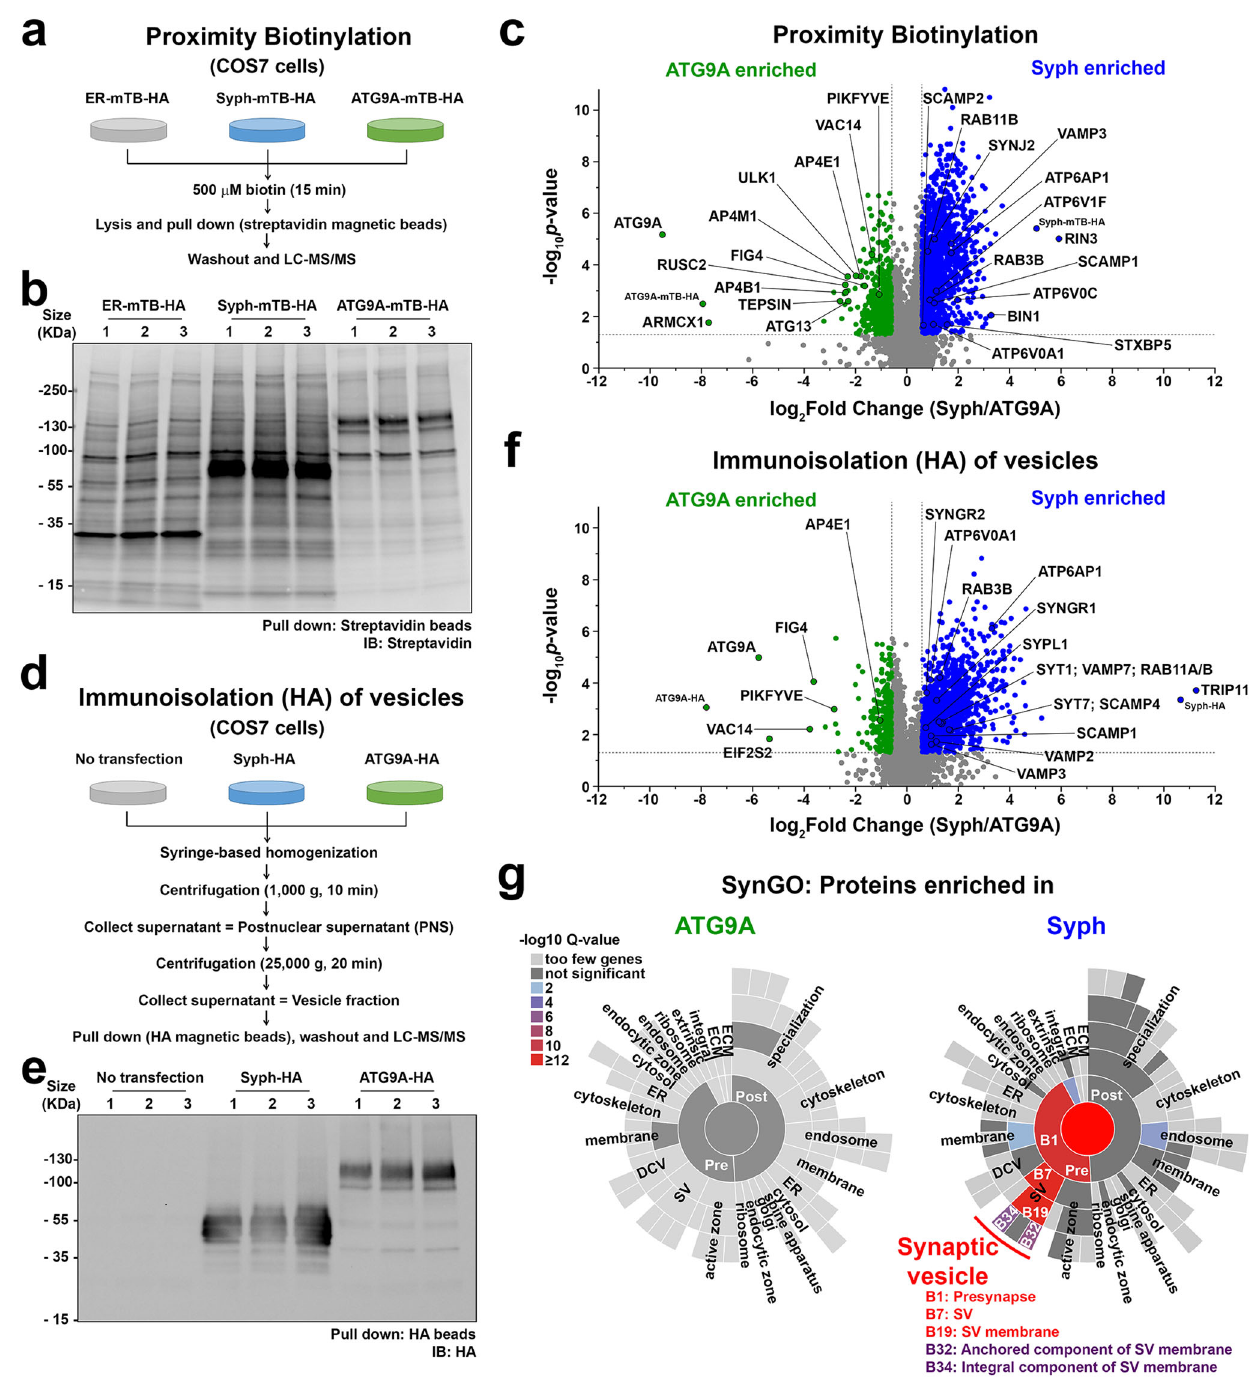
Fig. 5 | Proteomic analysisofATG9Aand synaptophysin vesicles. a – c Proximity labeling of synaptophysin and ATG9A vesicles using miniTurboID (mTB). a Experimental design. b Biotinylated proteins were af fi nity-puri fi ed on streptavi- din magnetic beads and detected by SDS-PAGE and blotting with IRDye680- streptavidin. See also Supplementary Fig. 8a – c. c, Volcano plot of the proteins identi fi ed by LC-MS/MS. Signi fi cant hits ( p -value<0.05 and absolute fold- change>1.5) are indicated in green (ATG9A enriched) or blue (synaptophysin enriched). p -valueswerecalculatedbythetwo-sidedpairedStudent ’ s t -test.Thelist of proteins can be found in Supplementary Data 1. d – f Immunoisolation of synaptophysin-HA and ATG9A-HA vesicles on anti-HA magnetic beads. d Experimentaldesign. e Asmallvesicleenrichedcellfractionwasimmunoisolated